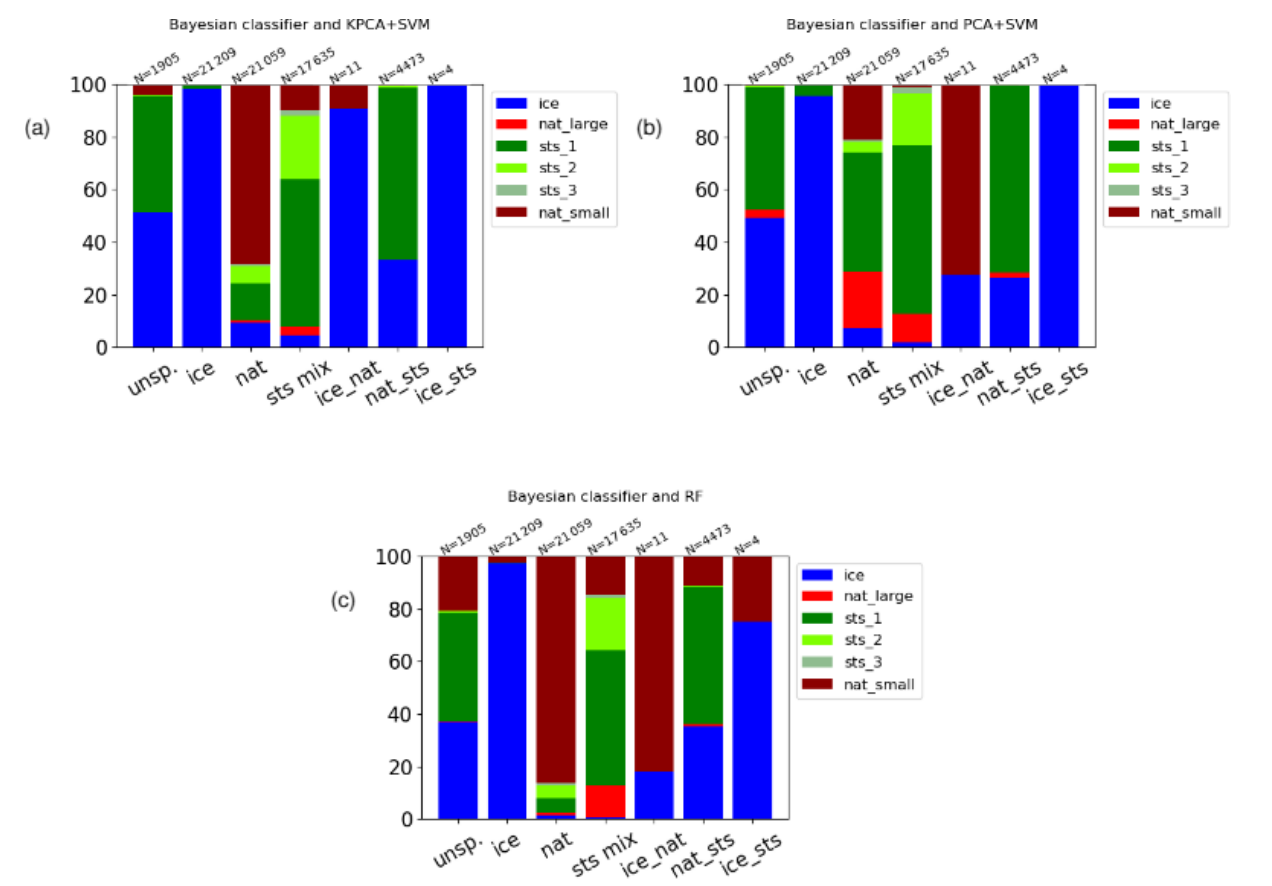
Figure 2. Intercomparison of ML and Bayesian classifiers for Southern Hemisphere winter (May to September 2009). Ticks on the x axis represent the classes of the BC. The y axis indicates the fraction of the classes as predicted by the KPCA + SVM (a) , PCA + SVM classifier (b) , and the RF classifier (c) . N is the number of samples belonging to each class of the Bayesian classifier.